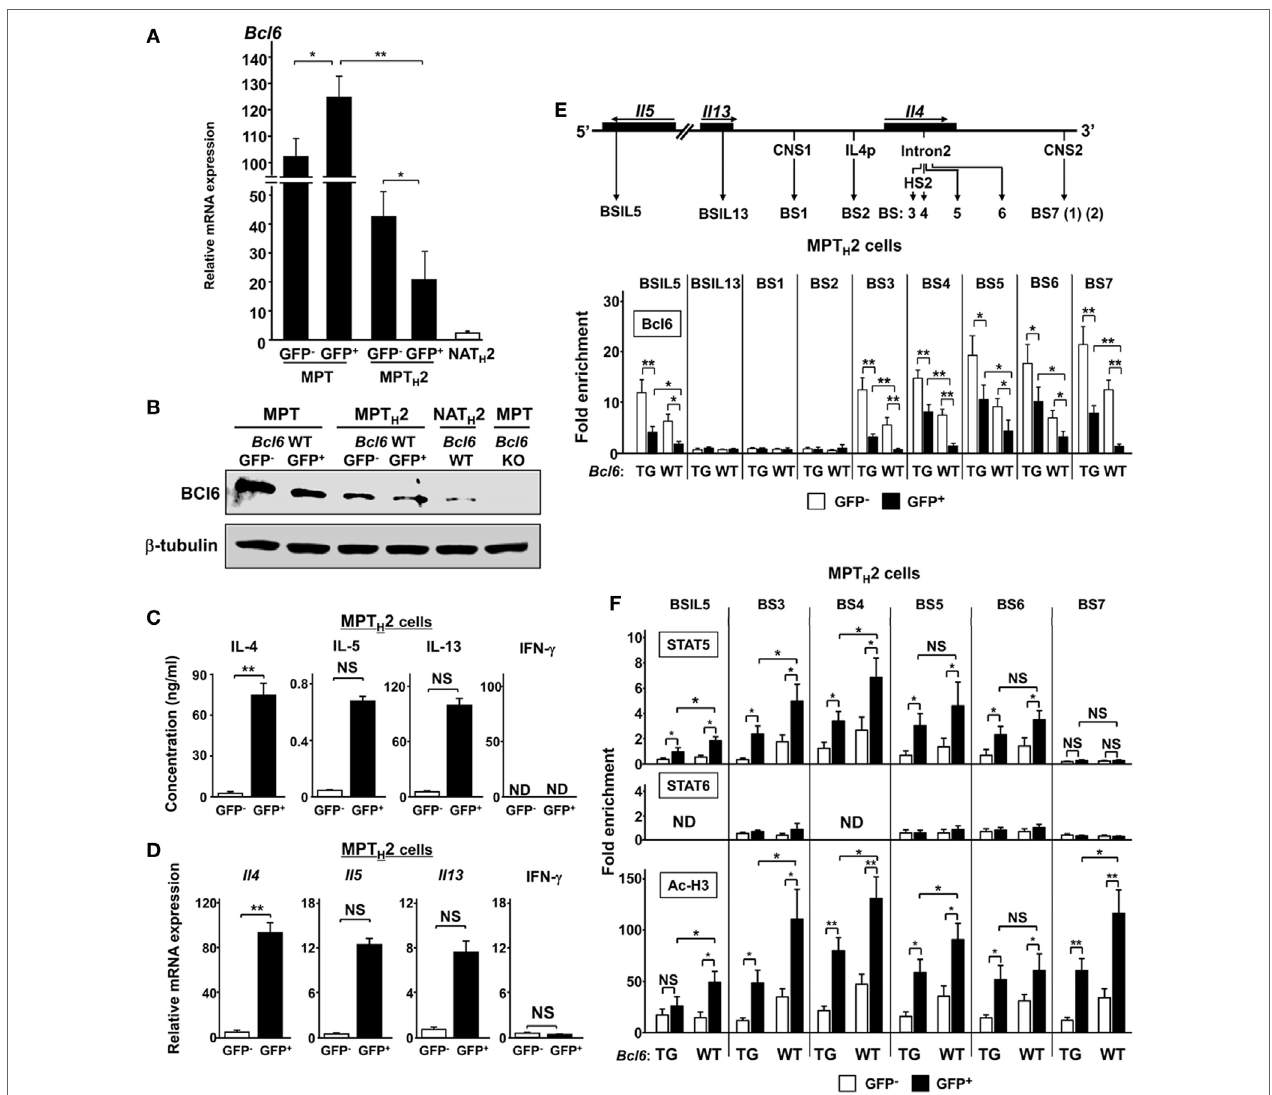
FigUre 3 | Role of Bcl6 and signal transducer and activator of transcription (STAT) binding to the Il4 locus MPT cells. (a) Bcl6 mRNA levels in GFP + and GFP − MPT cells, GFP + and GFP − MPT H 2 cells, and NA T H 2 cells, as measured by qRT-PCR. (B) Western blot analysis of Bcl6 protein in GFP + and GFP − MPT cells MPT ( Bcl6 -WT) and MPT cells ( Bcl6 -KO) in the spleen and GFP + and GFP − MPT H 2 cells ( Bcl6 -WT). Data are representative of three independent experiments. (c,D) KJ1-26 + cells among MPT cells from the spleens of Bcl6 -WT-CNS2-GFP-TG DO11.10 mice were cultured with ovalbumin peptides and antigen-presenting cells in vitro for 7 days under T H 2 conditions. Cells were restimulated with anti-CD3 and anti-CD28 monoclonal antibodies. After 48 h, IL-4, IL-5, IL-13, and IFN- γ levels in culture supernatants were measured by ELISA (c) . After 8 h, the mRNA levels of Il4 , Il5 , Il13 , and Ifn- γ were measured by qRT-PCR (D) . [ (e) , top] Diagram of T H 2 cytokine gene loci, with regulatory regions indicated by arrows [CNS, gene promoter regions (p), and Bcl6/STAT (BSs): IL5BS in Il5 ; IL13BS in Il13 intron 1; BS1 and BS7 (1) (2) in CNS1 and CNS2, respectively; BS2 in Il4 p; and BS3, BS4, and BS5 in Il4 intron 2]. (e,F) Bcl6 levels [ (e) bottom], STAT5 and STAT6 binding, and Ac-H3 (F) at each BS were analyzed by chromatin immunoprecipitation assay for CNS2-active (GFP + ) (closed bar) and CNS2-inactive (GFP − ) (open bar) MPT H 2 cells. All results are representative of three (a,c,D) or four (e,F) independent experiments with similar outcomes. Data are presented as the mean ± SEM ( n = 7–9). * P < 0.05, ** P < 0.01, comparison between two groups is indicated. Ac-H3, acetylated histone H3; CNS, conserved noncoding sequence; BS, binding sequence; Bcl6, B-cell lymphoma 6; GFP, green fluorescent protein; KO, knockout; ND, not detected; MPT cell, memory phenotype CD4 + T cell; MPT H 2 cell, MPT cell-derived T H 2 cell; NA, naïve; TG, transgenic; WT,